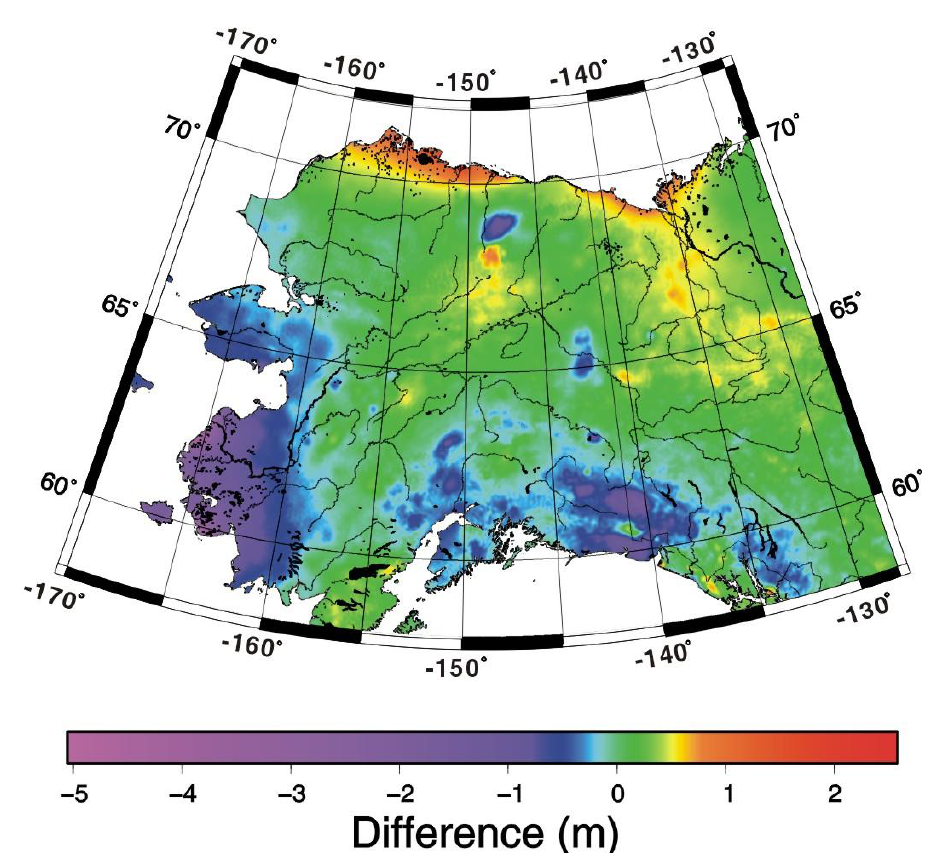
Figure 5. Geoid-difference model 1-arc minute (about 2-km) grid of geoid change from 1999 through